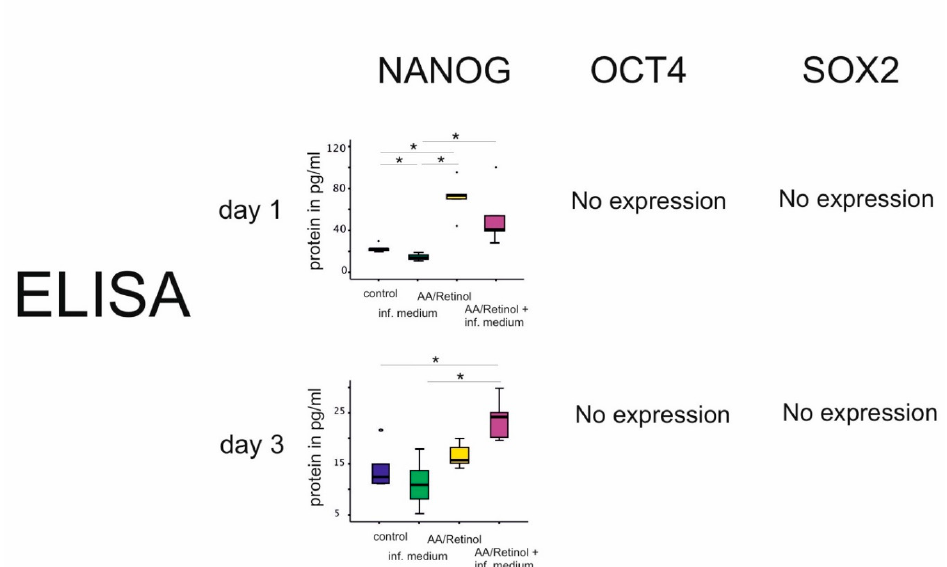
Figure 2. mRNA and protein expressions of stemness markers ( NANOG , OCT4A , SOX2 ) in G-MSCs challenged by AA/retinol and inflammation at 1, 3, 5, and 7 days (box and whisker plots with medians/quartiles). Significant differ- ences denoted with asterisks ( n = 5; * p < 0.05, Friedman test). Abbreviations: SOX2 : sex-determining region Y-box 2; OCT4A : octamer-binding transcription factor 4A.